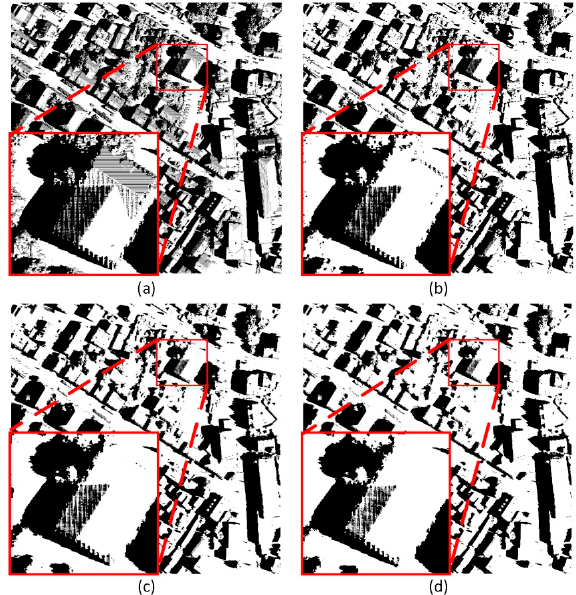
Figure 11. The results with different numbers of disregarded pixels in the geometric shadow detection process (the image resolution is 0.09 m): ( a ) original result; ( b ) disregarding 10 pixels; ( c ) disregarding 15 pixels; and ( d ) disregarding 20 pixels.